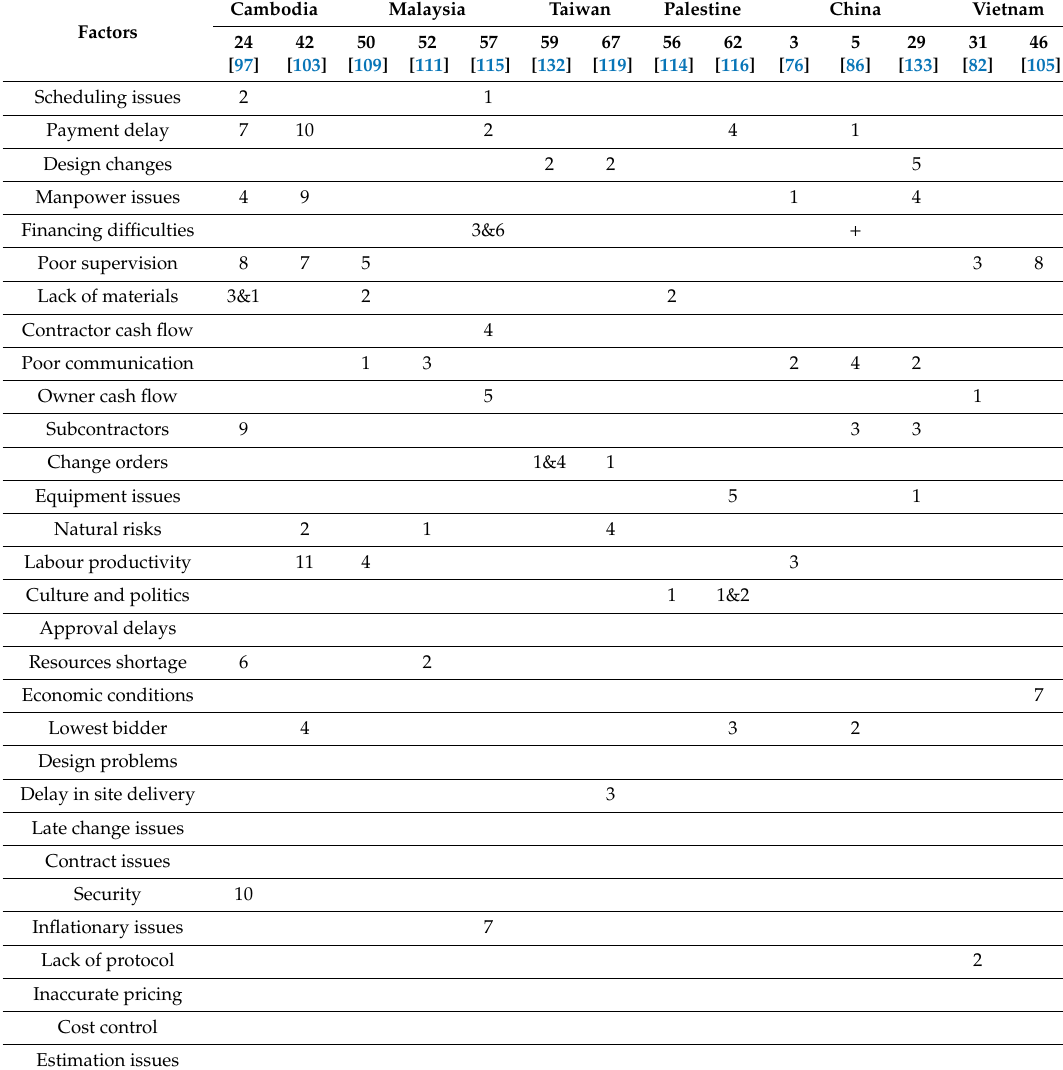
Table 7. Priority list of delay factors within DEC literature for selected Asian